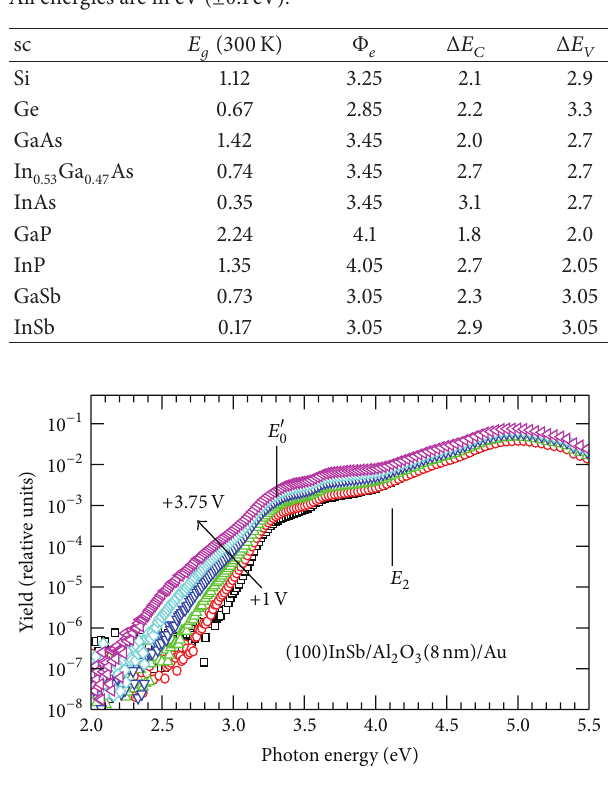
O ( 𝐸 𝑔 = 6.1 eV). 2 3